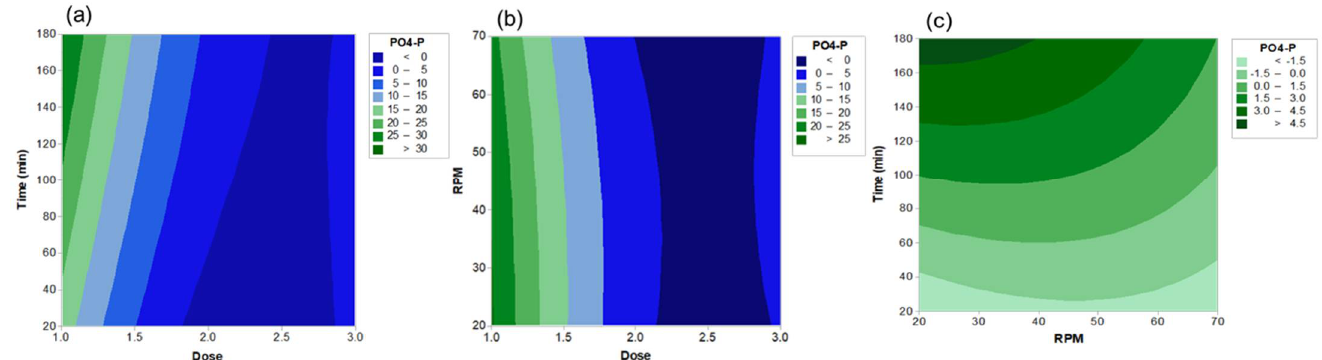
Figure 4. Contour plots of the responses of the residual [PO 4 -P] according to PAC dose (Dose), slow mixing time (Time) and slow mixing speed (RPM). Cross-sections are shown for ( a ) Dose × Time, ( b ) Dose × RPM or ( c ) Time × RPM.